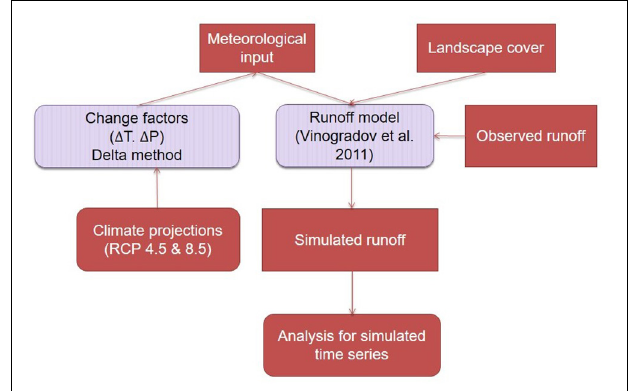
FIGURE 3 | Runoff change assessment